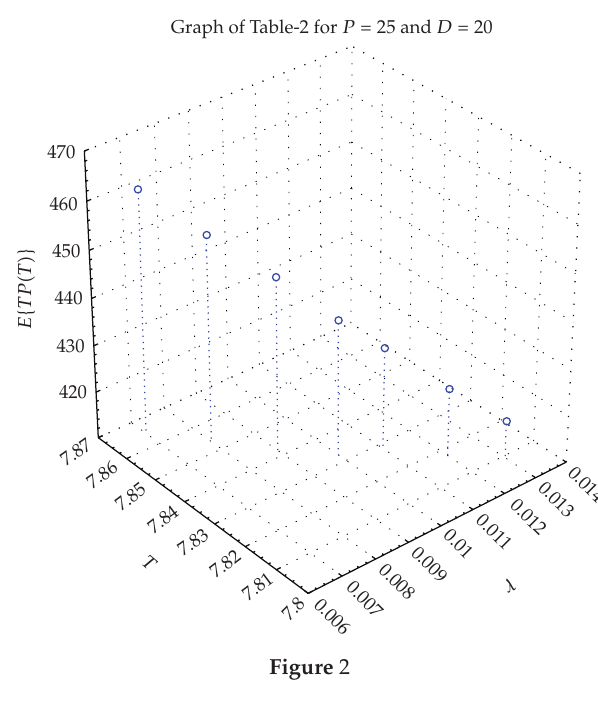
Graph of Table-2 for P (cid:9) 25 and D (cid:9)